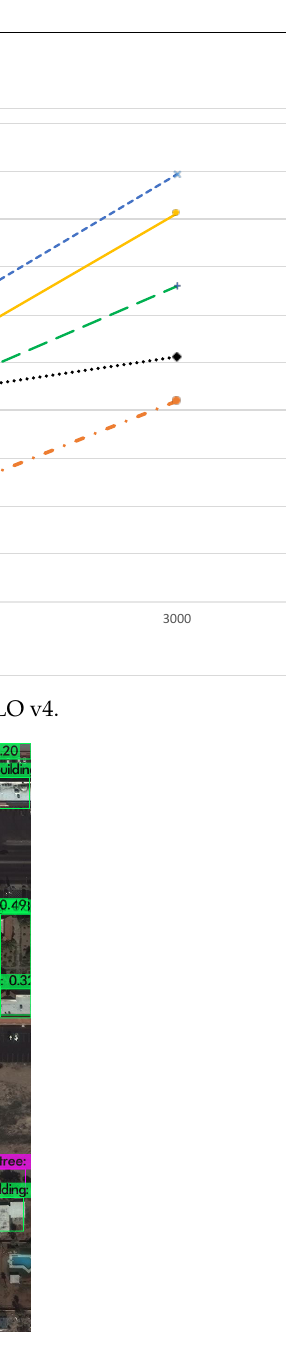
Figure 10. Sample of YOLO v4 results over Lisbon, Portugal, showcasing detection of multiple